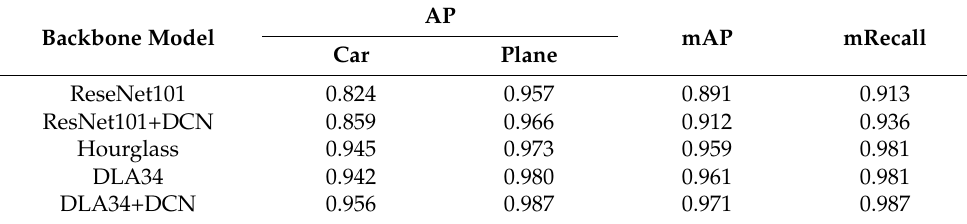
Table 4. Evaluation results of different backbone models used on the UCAS-AOD